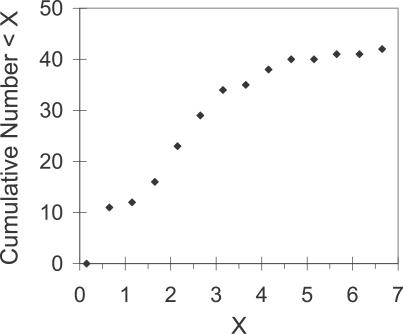
Cumulative Distribution of IMI PIM SizesThe values are calculated in bins of .5 h from .15 h to 6.15 h. The IMIs were measured at night; those that began or ended in daytime, and the PIM and the following IMI, were excluded. Less than 10% of the IMIs following PIMs are longer than 4.15 h.